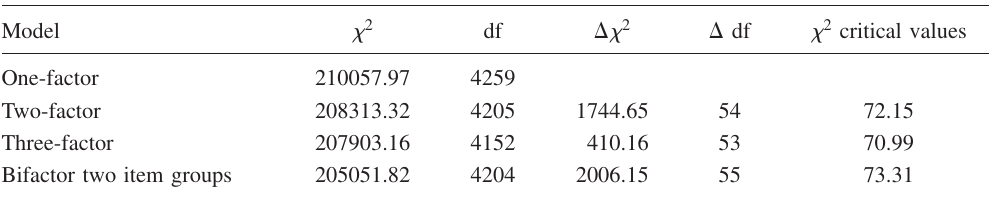
TABLE V. Comparisons between one-, two-, and three-factor models and a bifactor model with guess